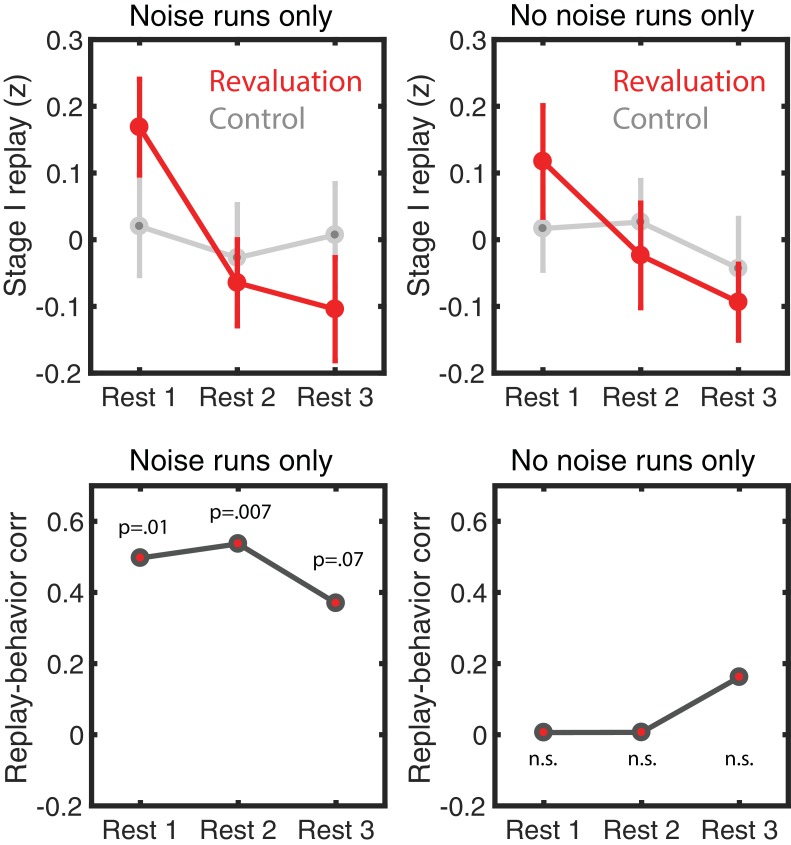
Breakdown of replay during the three rest periods in the revaluation vs. control conditions during noiseless rewards and noisy rewards conditions (top) and the correlation of these replay magnitudes with revaluation magnitude (bottom) in the noiseless vs. noisy rewards conditions.